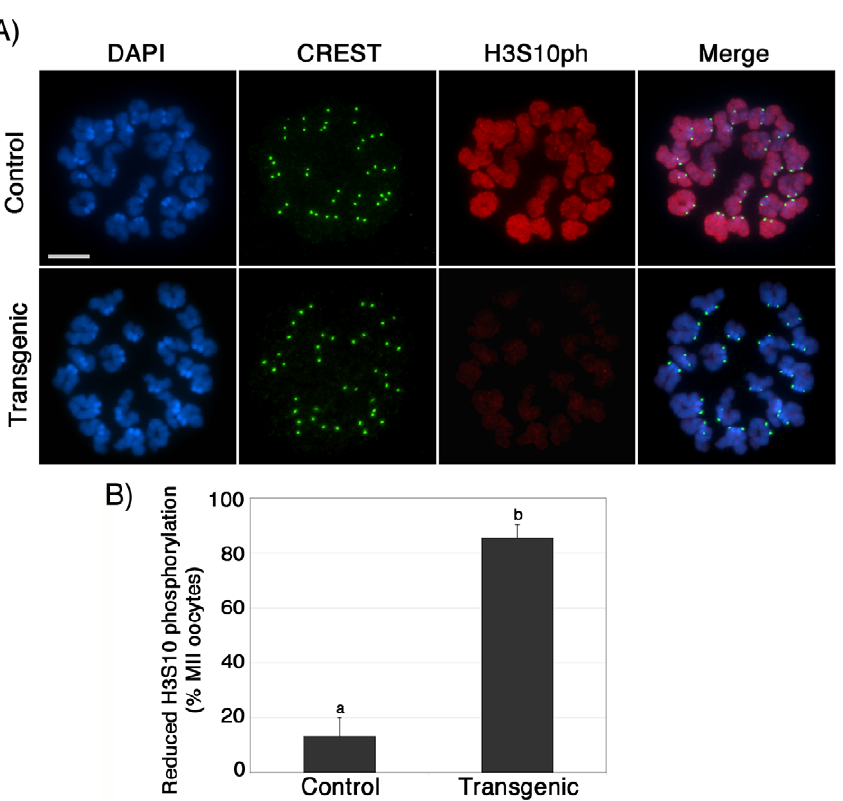
Figure 5. Reduced phosphorylation of histone H3 at serine 10 (H3S10ph) in the chromosomes of ATRX-deficient oocytes. ( A ) Phosphorylation of H3S10 (red) was visualized in metaphase II chromosome spreads from control (upper panel) and transgenic (lower panel) oocytes. Control oocytes exhibit prominent chromosome-wide H3S10ph staining. In contrast, a high proportion of transgenic oocytes exhibit negligible H3S10ph staining at pericentric heterochomatin and throughout the chromatids. CREST immunochemistry (green) served as an experimental control. ( B ) Proportion of oocytes with reduced phosphorylation of H3S10 in transgenic oocytes and controls. Data are presented as the mean 6 s.d. of three independent experiments (p , 0.05). Scale bar =10 m m.